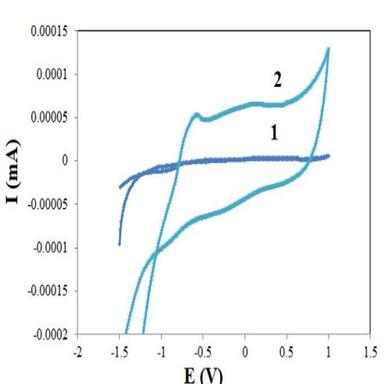
Cyclic voltammograms obtained by GO-imi- (CH2)2-NH2-CPE and CPE at 100 mV/s in buffer solution.